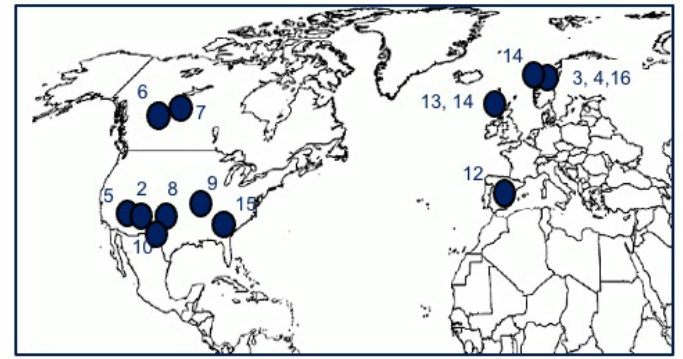
Figure 1. Map showing the locations of seismic data cited in this paper. The numbers refer to the figures in this paper.